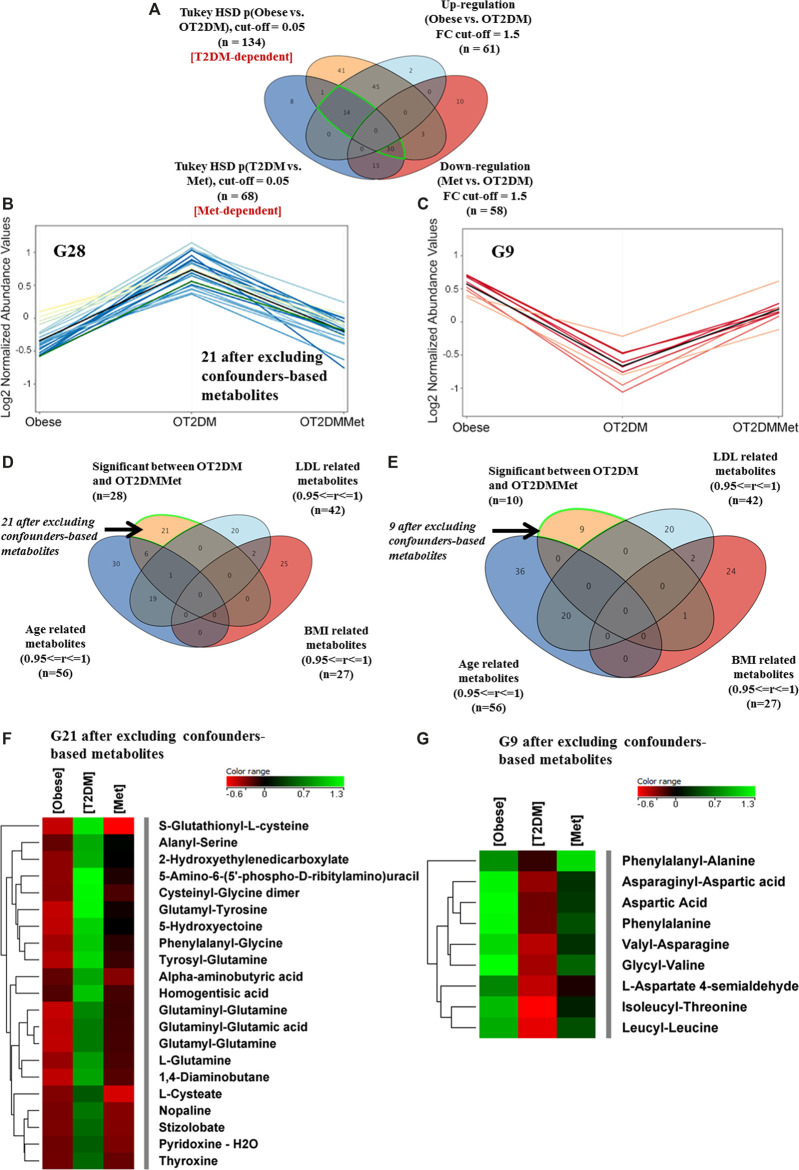
Metabolic changes of metformin administration in obese diabetic patients (A) Venn diagram illustrates the filtration of the significant metabolites for T2DM (G134) (Obese vs. OT2DM groups), and metformin (G68) (OT2DM vs. OT2DMMet groups) based on the fold change trend (cutoff >1.5, and <0.67) (B) 28 metabolites have been upregulated as of diabetes and returned to obese comparable levels after metformin administration (C) Levels of another 9 metabolites were downregulated in T2DM and returned to obese comparable levels after metformin administration (D,E) Venn diagrams demonstrate the exclusion of the confounders-based metabolites from G28 and G10, which were reduced to G21 and G9, respectively (F, G) Heat maps of the identified features (G21 and G9) that were-upregulated and down-regulated, respectively, after excluding the confounder-based metabolites as of T2DM effect in obesity and return to initial condition after metformin administration.